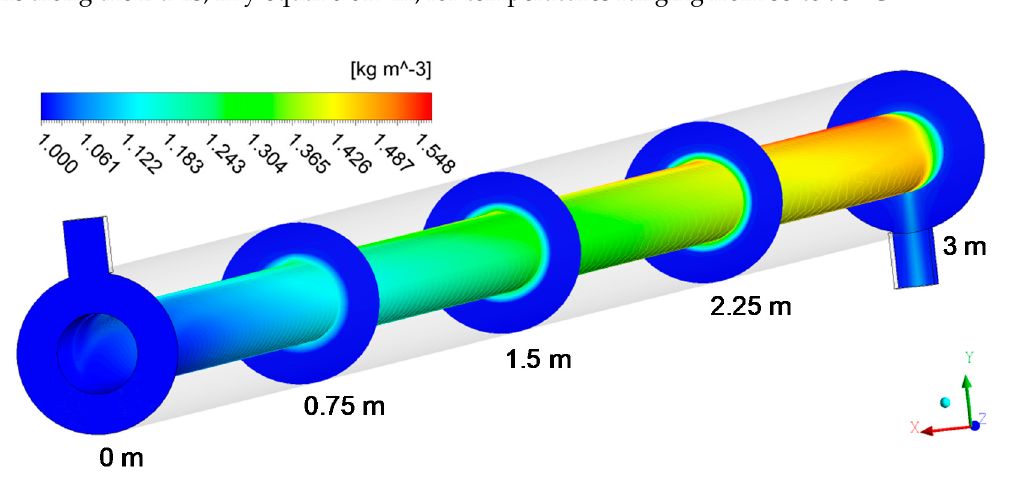
Figure 13. Oil concentration field inside the shell and tube module for T 0 = 35 °C (Case 5).